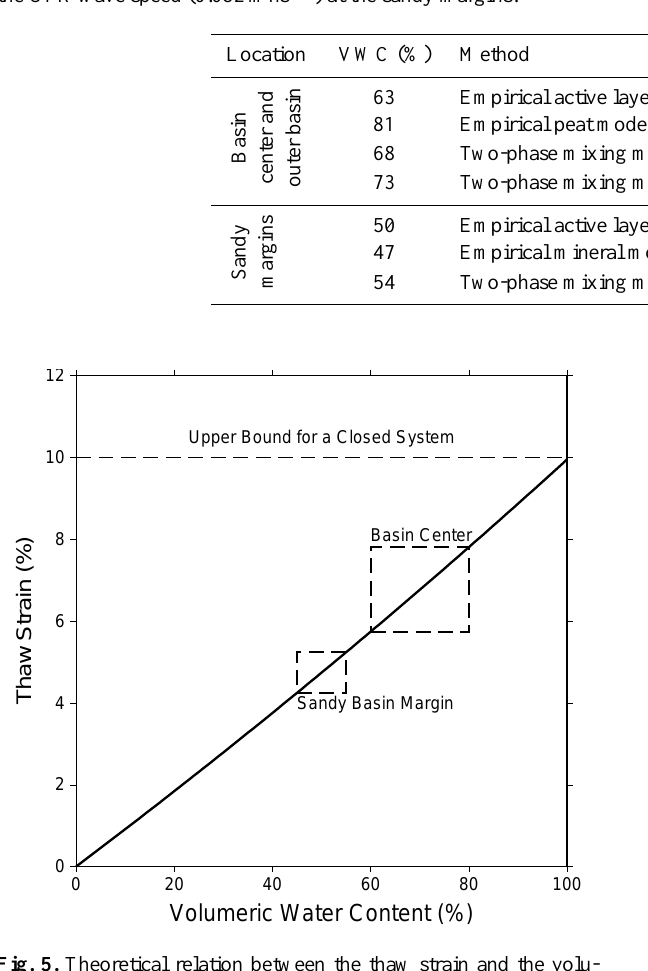
Table 1. Volumetric water content (VWC, θ ) estimated based on the GPR wave speed (0.042mns − 1 ) at the basin center and outer basin, and the GPR wave speed (0.052mns − 1 ) at the sandy margins.